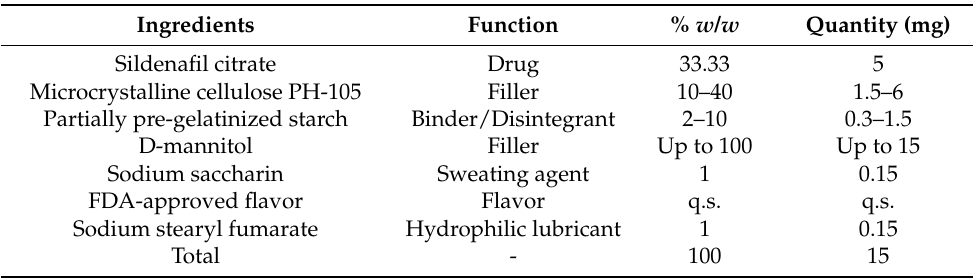
Table 3. Formulation used in the preparation of